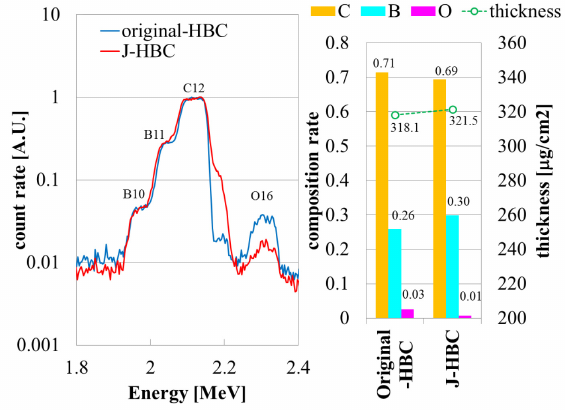
Fig. 5. Comparison of RBS spectra of original HBC foil and J-HBC foil (left), and analysis results for composition ratio and foil thickness estimation